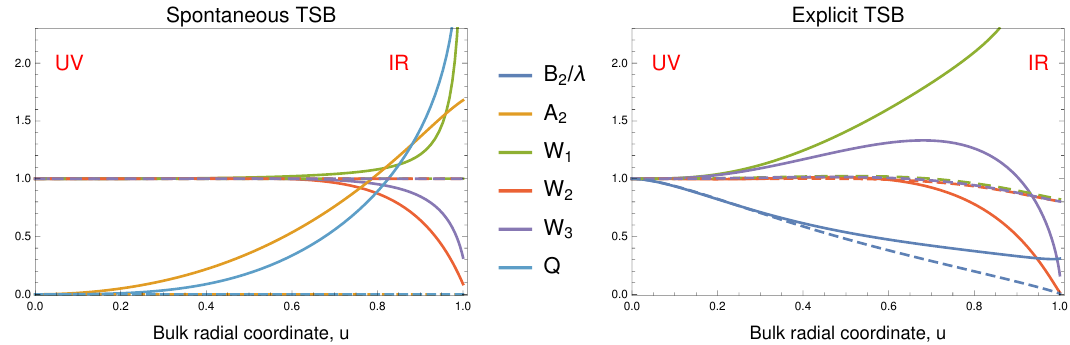
Figure 1 . Background pro(cid:12)les in cases of spontaneous (left) and explicit (right) translation sym- metry breaking. Solid lines show the cases when the TSB is relevant at the horizon, and we use dashed for the irrelevant ones. It is clearly seen that in the relevant case the (cid:12)eld W 1 diverges at the horizon, while W 2 and W 3 vanish. In the irrelevant case the W i are all equal. The parameters used for the explicit case are: (cid:21) = 3 (cid:22) for relevant, (cid:21) = 1 (cid:22) for irrelevant and T = 0 : 002 (cid:22) , p=(cid:22) = 1, p (cid:20) = 1 = 2. For spontaneous: (cid:21) = 0 : 05 (cid:22) , T = 0 : 005 (cid:22) , p=(cid:22) = 1, (cid:13) = 1 : 7, the irrelevant case is